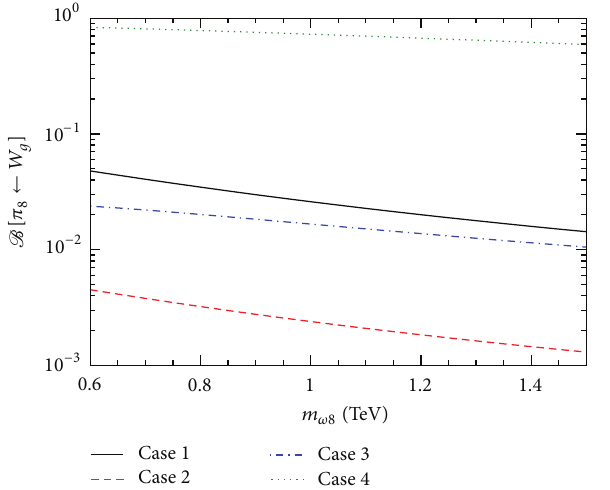
Figure 12: Branching ratio B (𝜋 8 → 𝑊𝑔) for the four parameter sets, ranging from predominance (Case 4), to below 10 −2 (Case 2).